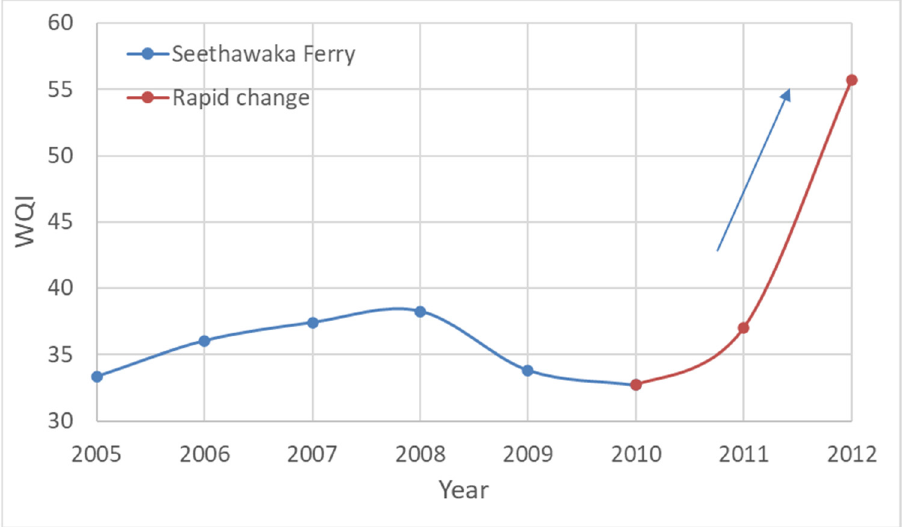
Figure 5. WQI variation at Seethawaka ferry sampling point.